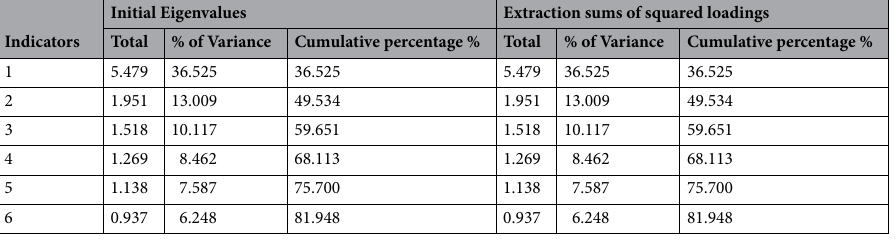
Table 2. PCA weight based on eigenvalues and